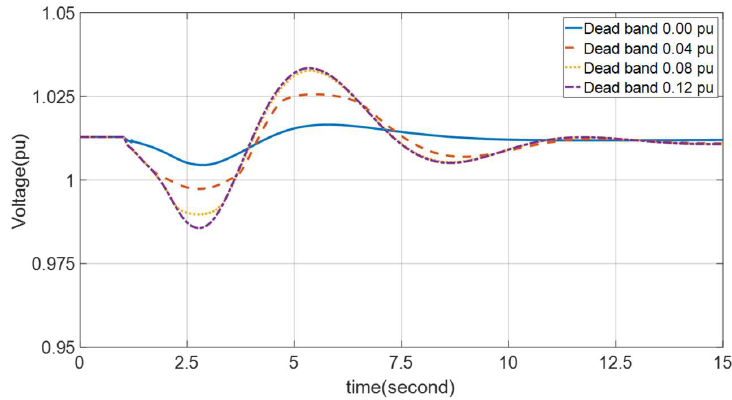
Figure 11. Voltage profile due to small disturbance.